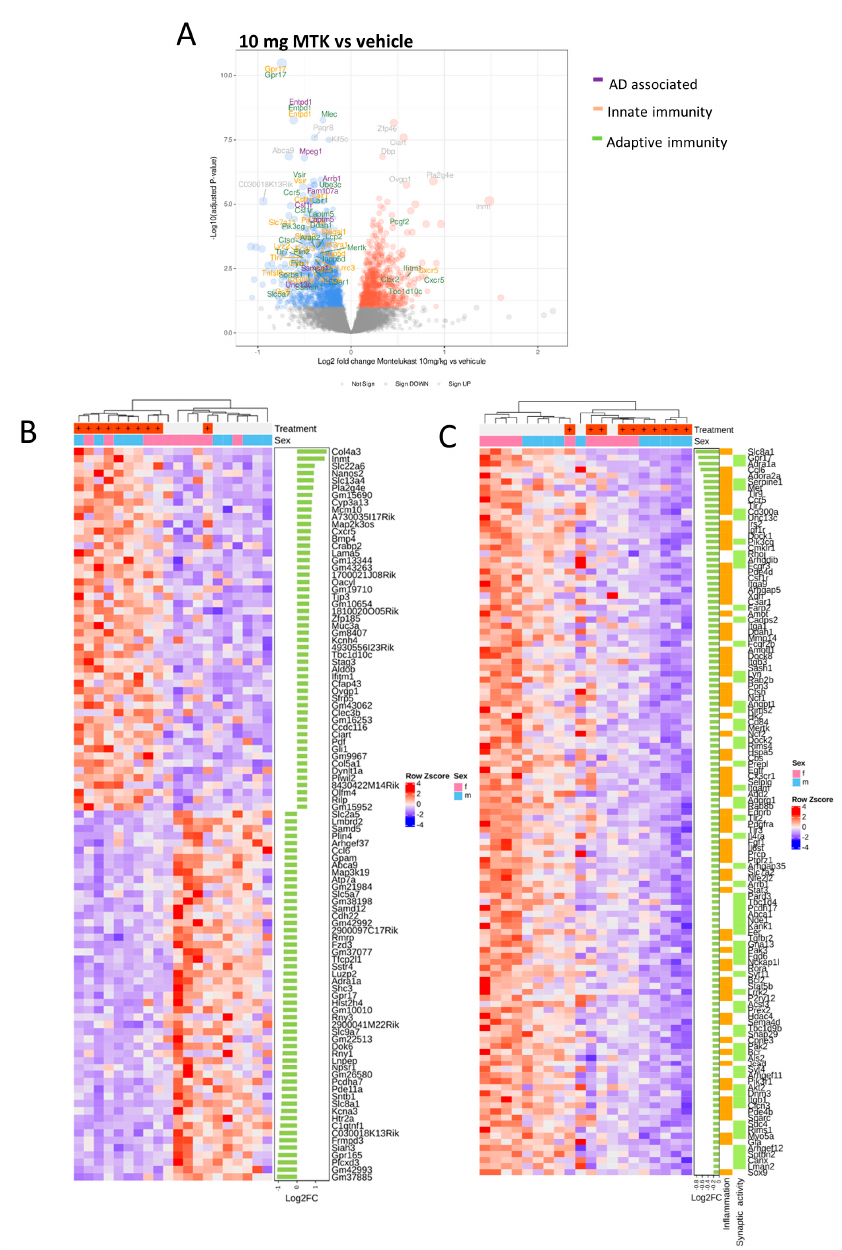
Figure 2. MTK alters the gene expression profile in 5xFAD mice. Gene expression data from hippocampal tissue ( n = 10/group). Only tissues from the vehicle and high-dose (10 mg/kg/d) groups were used in this analysis. ( A ) Volcano plot showing differentially expressed genes (DEGs) in high dose- versus vehicle-treated groups. Significantly upregulated DEGs are depicted in red and significantly downregulated DEGs are depicted in blue. Gene names associated with the terms innate immunity (yellow), adaptive immunity (green) and Alzheimer’s disease (AD) (purple) are highlighted. ( B ) Heatmap showing the top 50 significantly up- and downregulated genes. ( C ) Genes from GO annotations that fit into the broad terms inflammation and synaptic activity are the top downregulated biological processes. Here, the respective genes are shown in a heatmap.